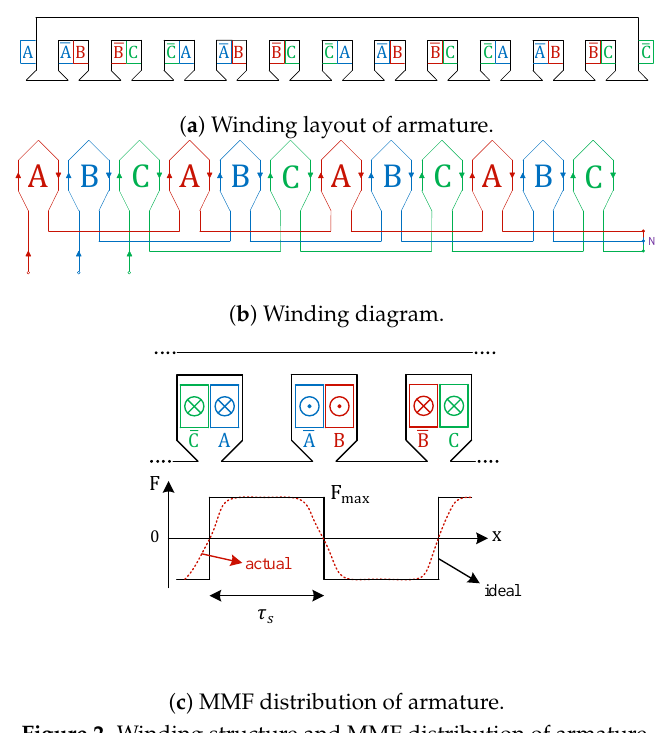
Figure 2. Winding structure and MMF distribution of